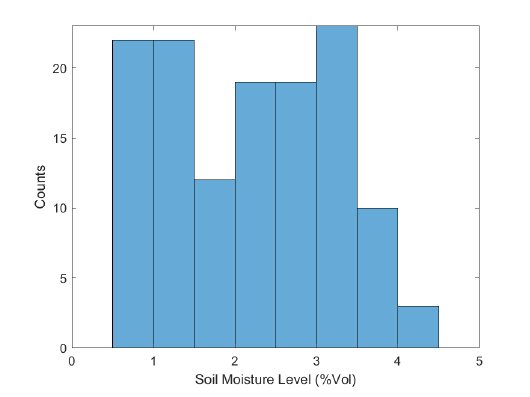
Figure 7. Soil moisture level distribution of data